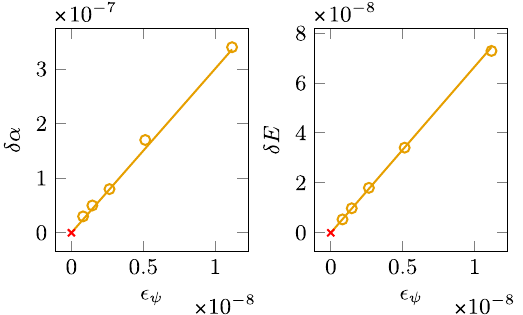
FIG. 4. Example of truncation error extrapolation of order parameter and ground-state energy for a chain of length L ¼ 100 at attractive interaction U ¼ − 4 t and density n ¼ 0 . 5 and t ⊥ ¼ 0 . 05 t . The y axes represent difference of order parameter δα ¼ α ð ϵ − α ð 0 Þ and similarly for energy. The range of MF ψ Þ terms taken into account is r ¼ 4 .